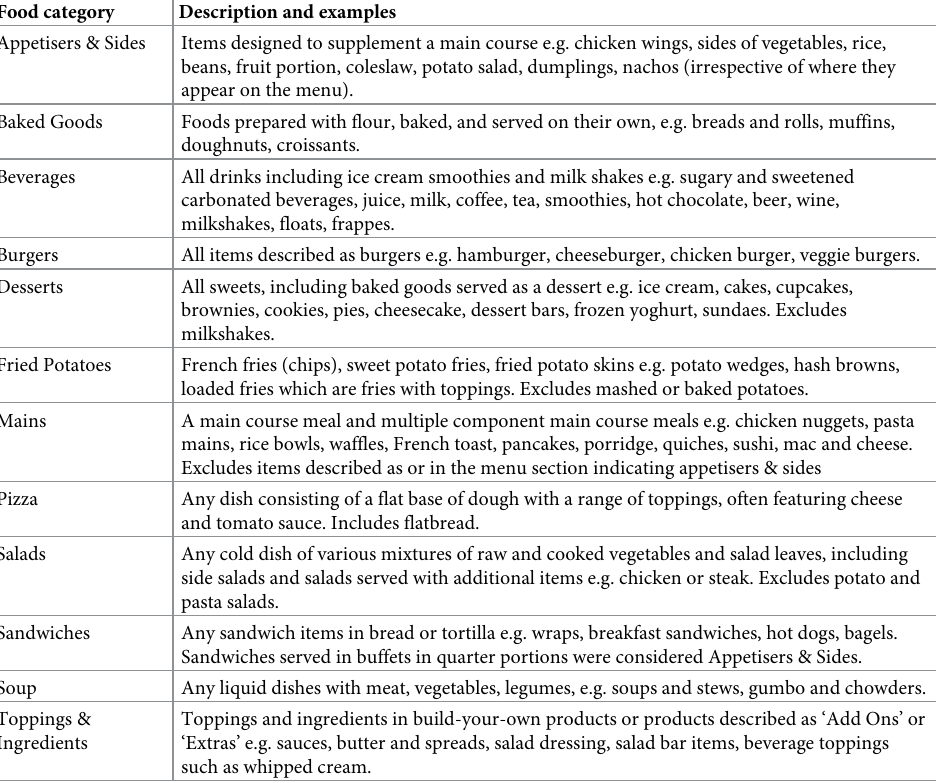
Table 1. Food categories and descriptions. Food